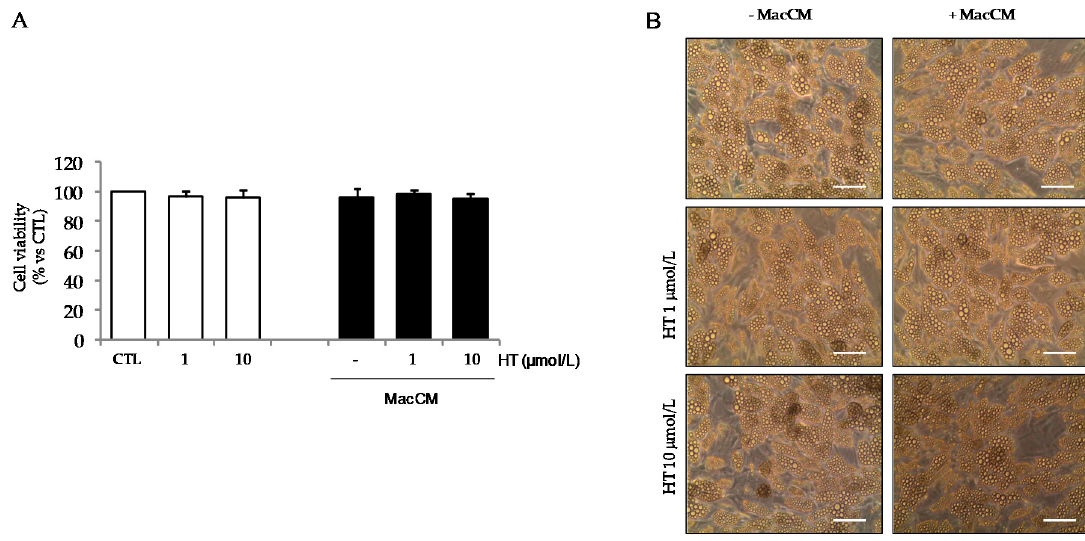
Figure 4. The effect of macrophage-derived conditioned medium treatment on adipocyte viability. SGBS adipocytes were pretreated with HT (1 h) at the concentrations indicated, and then either treated with macrophage-derived conditioned medium (MacCM) (black-filled bars), or left untreated (open white bars), for 18 h. ( A ) Cell viability was assessed by the MTT assay, and expressed as percent of untreated control (CTL). Data are means ± SD ( n = 3). In ( B ), representative phase-contrast images of SGBS cells after treatments are shown. Scale bar = 50 μ m.